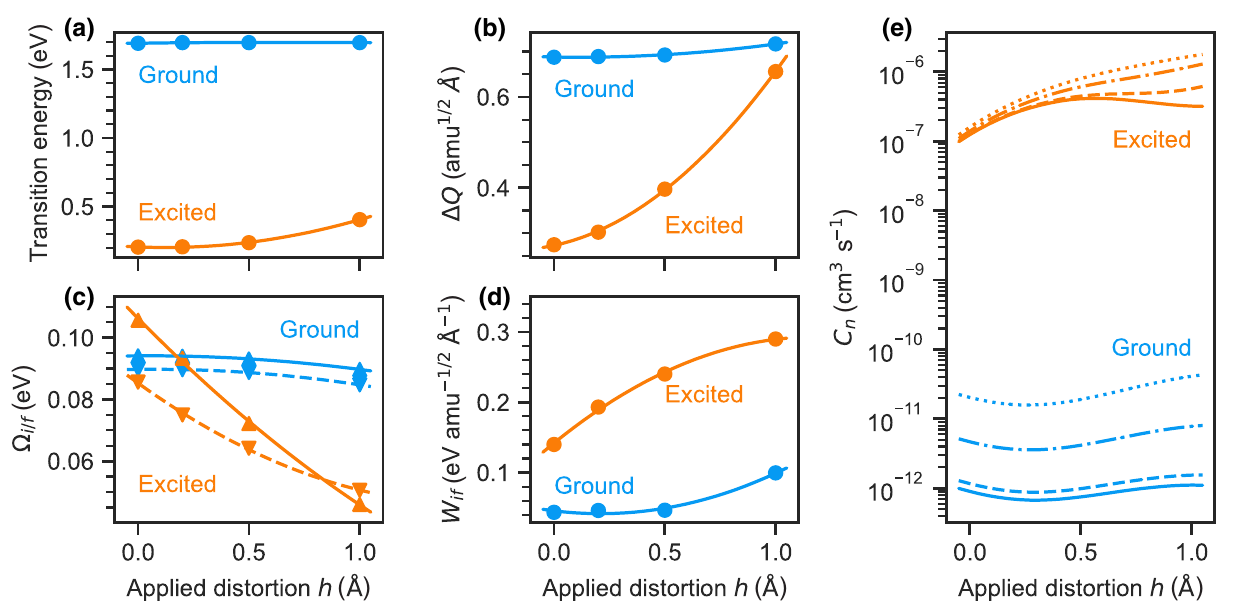
FIG. 15. Calculated parameters and capture coefficient for capture of an electron from the conduction band into the neutral boron dangling bond, as a function of applied distortion h . Calculated (a) transition energy, (b) mass-weighted root-mean-square difference in atomic geometries, (c) initial (up triangle) and final (down triangle) phonon frequencies, and (d) electron-phonon coupling matrix elements. The lines are a quadratic fit to the calculated parameters and are intended to guide the eye. The calculated (e) electron capture coefficient at 10 K (solid), 300 K (dashed), 600 K (dash dot), and 900 K (dotted). The parameters for capture into the ground state are shown in blue and the excited state are shown in orange.